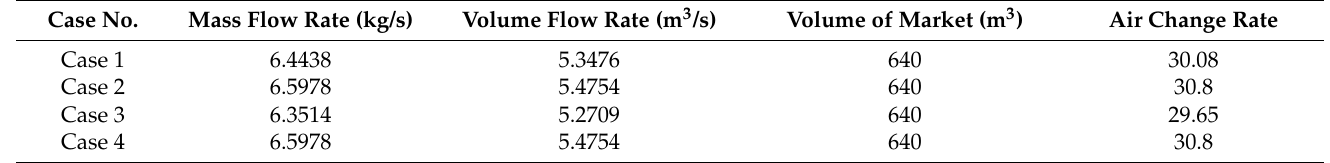
Figure 4. The velocity magnitude and streamlines at z = 1.6 m cross-section for ( a ) case 1 (only the front door is open); ( b ) case 2 (front and back doors are open); ( c ) case 3 (front, left, and right doors are open); ( d ) case 4 (front, back, left, and right doors are open). Table 4. General air change rate of the farmers’